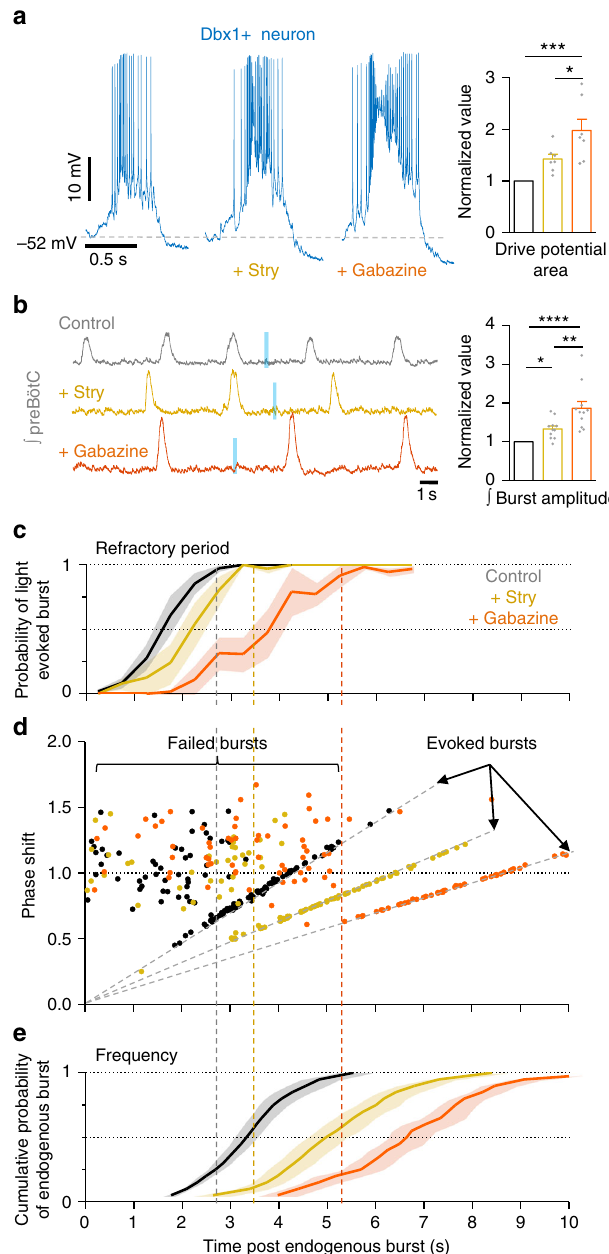
Fig. 3 Inhibition restrains excitatory preBötC neuron activity and the refractory period. a Example Dbx1 + neuron activity under baseline conditions and following progressive blockade of glycinergic and gabaergic synaptic inhibition with strychnine (1 µ M) and gabazine (1 µ M), respectively. Average normalized inspiratory drive potential area ( n = 7) of Dbx1 + neurons during preBötC bursts in strychnine and gabazine (* p < 0.05, ***p<0.001; means ± s.e.m.; one-way repeated measures ANOVA and Bonferroni ’ s multiple comparisons test). b Example of preBötC population activity from a Dbx1 -ChR2 slice during inhibition block and failure to light-evoke bursts during the refractory period, and normalized burst amplitude of integrated preBötC population activity ( n = 11 slices; * p < 0.05, ** p <0.01, **** p <0.0001; means ± s.e.m.; Friedman test and Dunn ’ s multiple comparisons test). c Quanti fi ed probability of evoking a burst (0.5 s bins) relative to time post endogenous burst (s) from Dbx1 -ChR2 slices during inhibition block (~100 – 150 trials in each condition from each slice; n = 4 slices; means ± s.e.m.). d Data from a representative Dbx1 - ChR2 stimulation experiment comparing the phase shift (stimulus